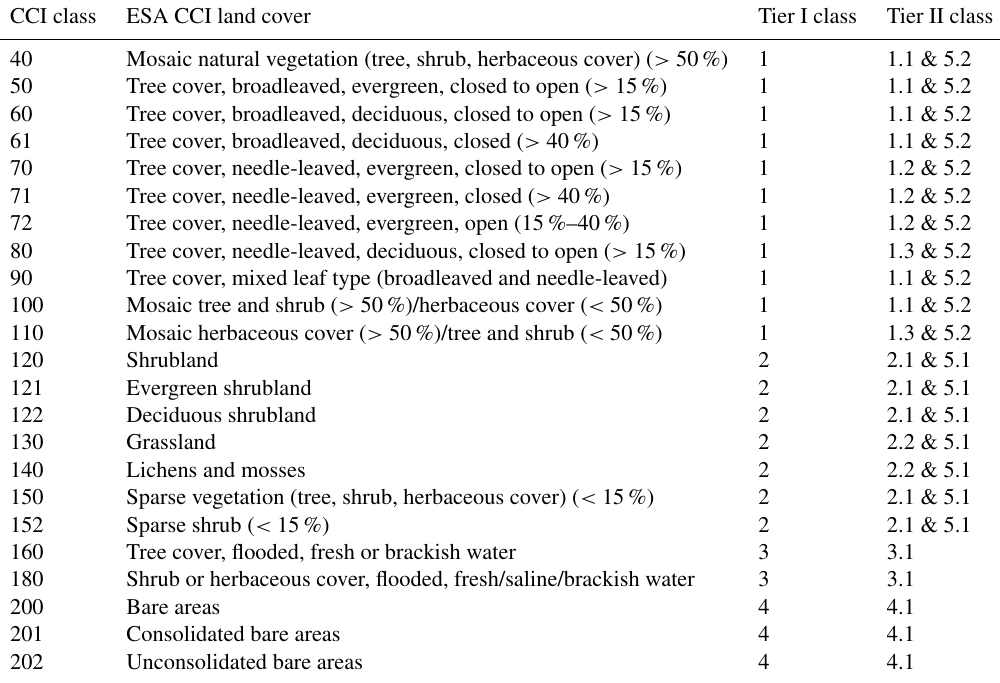
Table 3. Amalgamation of ESA’s CCI land cover classes with the Tier class system above the Yedoma deposits.